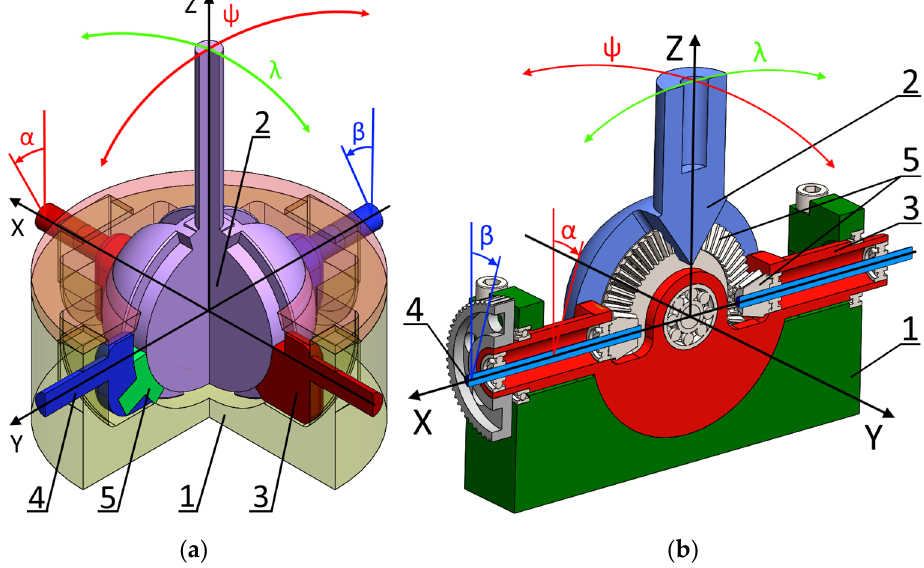
Figure 1. The reconfigurable joint designs: ( a ) an active 2R spherical mechanism-based joint; ( b ) differential gear-based joint.